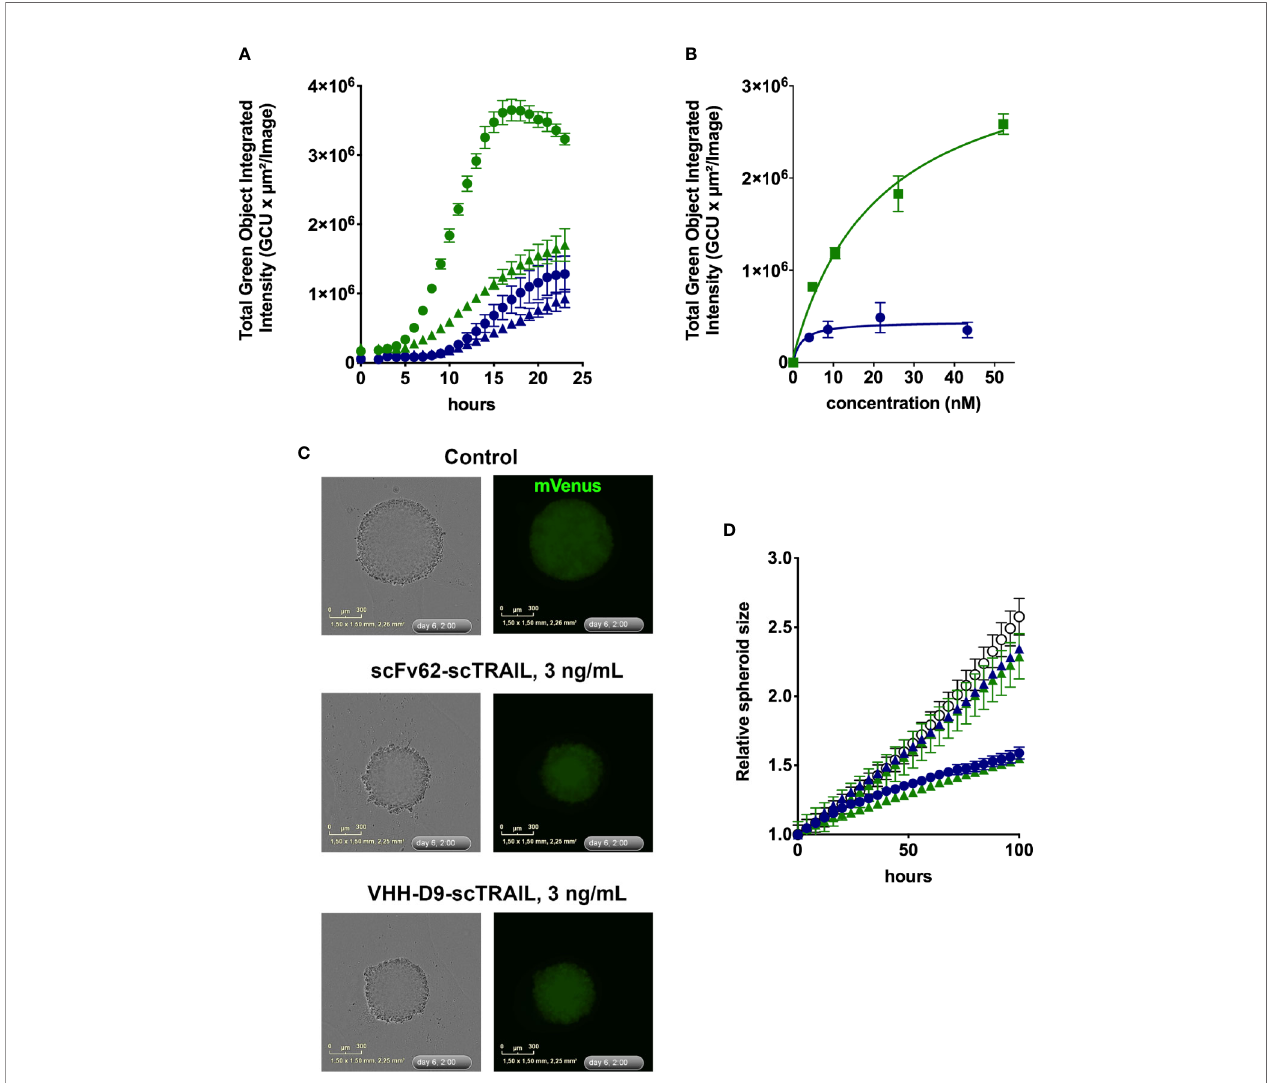
FIGURE 5 | Apoptosis induction by scFv62-scTRAIL and VHH-D9-scTRAIL on DU-145 cells. (A) Cells seeded in 96 well plates were treated with 370 pg/ml (triangles) or 3.7 ng/ml (circles) of scFv62-scTRAIL (corresponding to 4.3 pM and 43 pM, blue) or VHH-D9-scTRAIL (corresponding to 5.2 pM and 52 pM, green), and apoptosis was measured over time using a green fl uorescent caspase reporter. All conditions induced apoptosis, but especially VHH-D9-scTRAIL produced a large fraction of apoptotic cells as early as 8 h after the start of treatment. (B) Dose-response of the apoptosis induction by scFv62-scTRAIL (blue) and VHH-D9- scTRAIL (green). (C) Representative images of spheroids produced by fl uorescent (mVenus) DU-145 cells and submitted to the indicated treatments. (D) Relative size of the spheroids treated with the fusion constructs at 300 pg/ml and 3 ng/ml (corresponding to 4.2 and 42 pM for VHH-D9-scTRAIL and 3.5 and 35 pM for scFV62-scTRAIL). The values in response to lower doses of the constructs did not differ from the control (open black circles), while higher doses reduced spheroid size for both scFv62-scTRAIL (blue) and VHH-D9-scTRAIL (green). All data presented as means ±